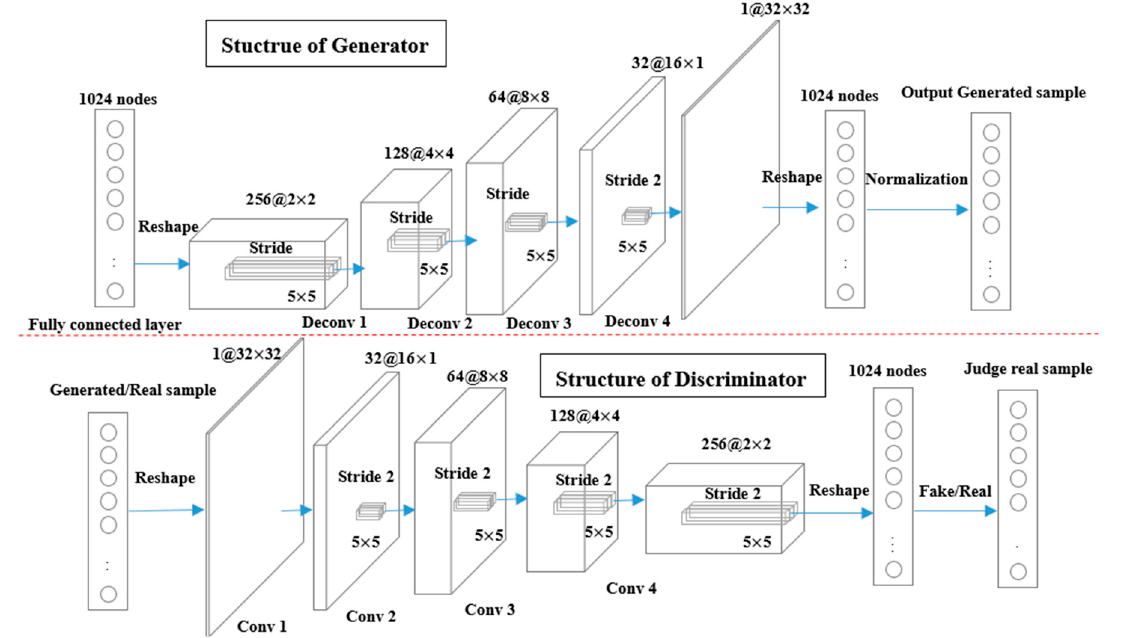
Figure 4. Structure diagrams of the designed GAN generator and discriminator.